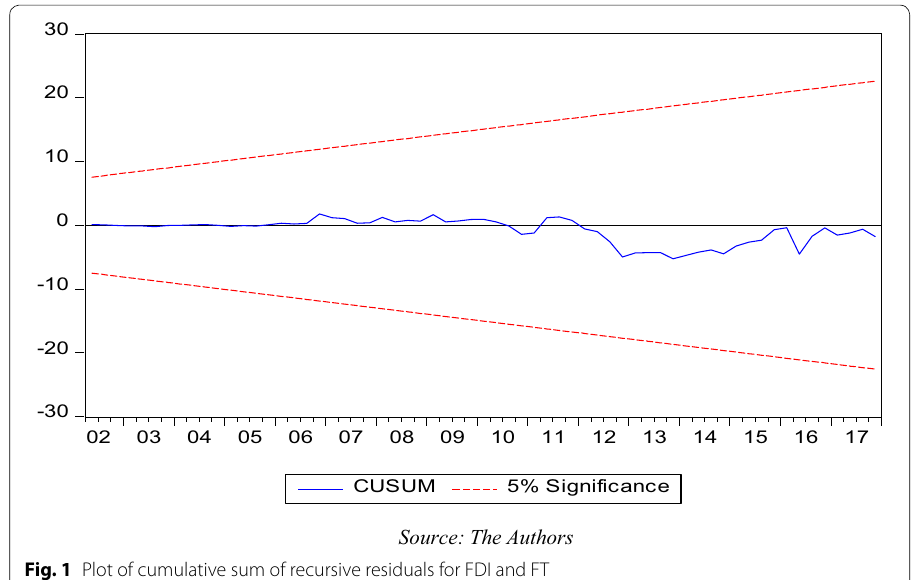
Fig. 1 Plot of cumulative sum of recursive residuals for FDI and